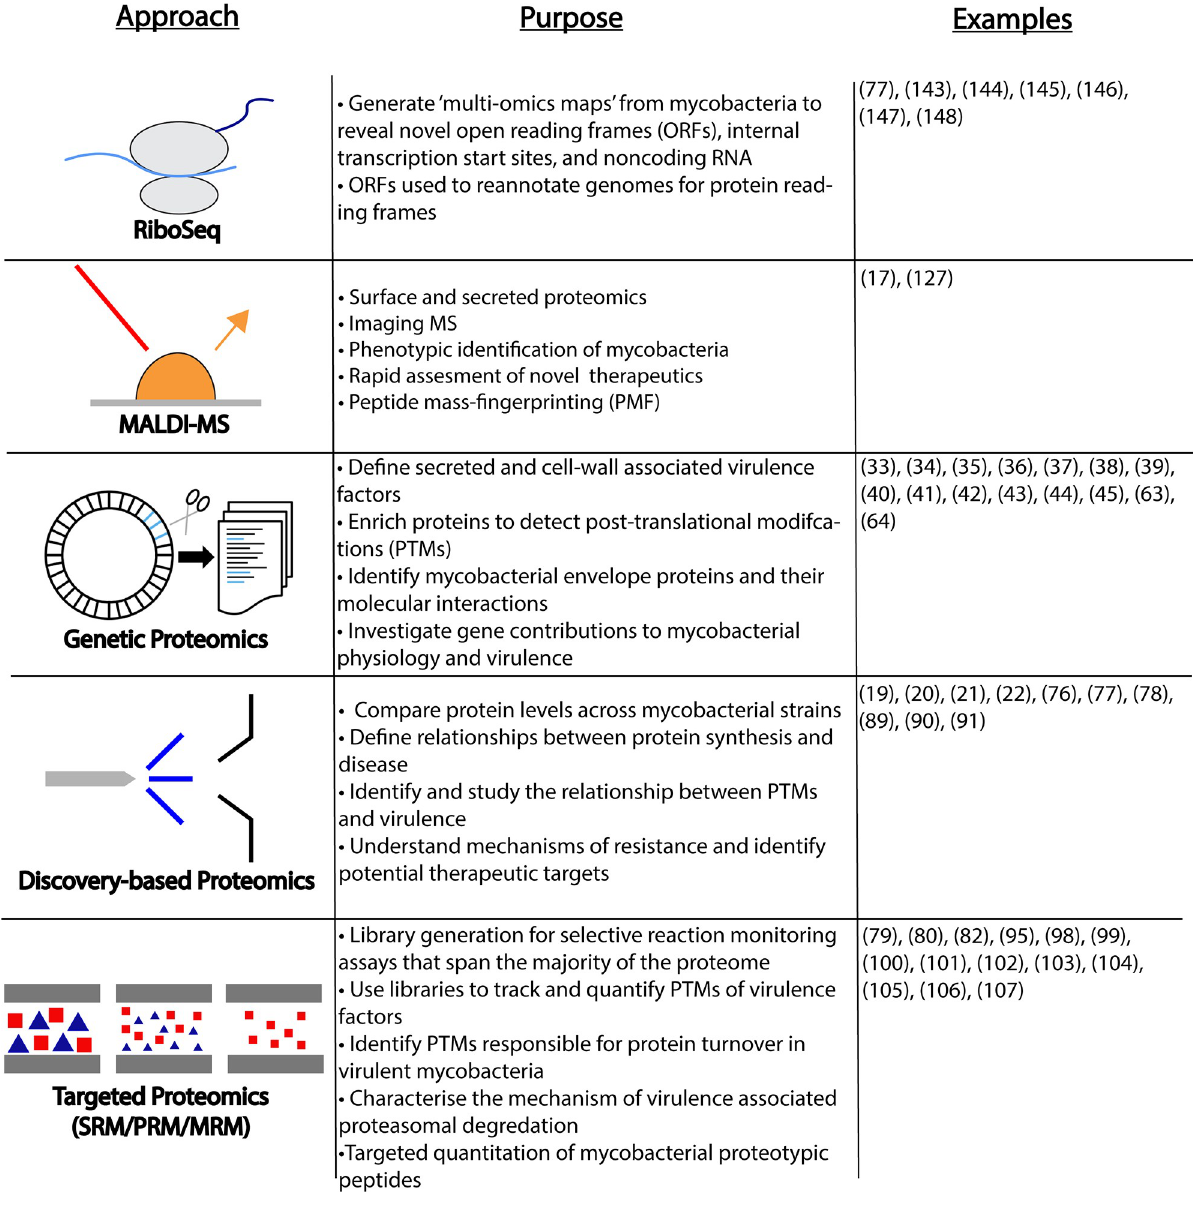
Fig 2. Proteome-centric approaches used in the study of mycobacteria described in this review. Listed are 5 major approaches, their associated measurements, and representative references. Ribo-seq methods measure the “translatome” and have been applied to annotate and define the mycobacterial genome landscape. MALDI-MS–based approaches are more rapid and are used in screening approaches. Genetic proteomics uses alterations in the genome to manipulate the measured proteome. Discovery and targeted proteomics approaches measure and quantify proteins and their modification from complex and enriched cellular material. Examples list numbers of relevant references. MALDI-MS, matrix-assisted laser desorption/ionization mass spectrometry; MRM, multiple reaction monitoring; ORFs, open reading frames; PMF, peptide mass-fingerprinting; PRM, parallel reaction monitoring; PTMs, posttranslational modifications; Ribo-seq, ribosome sequencing; SRM, selected reaction monitoring.